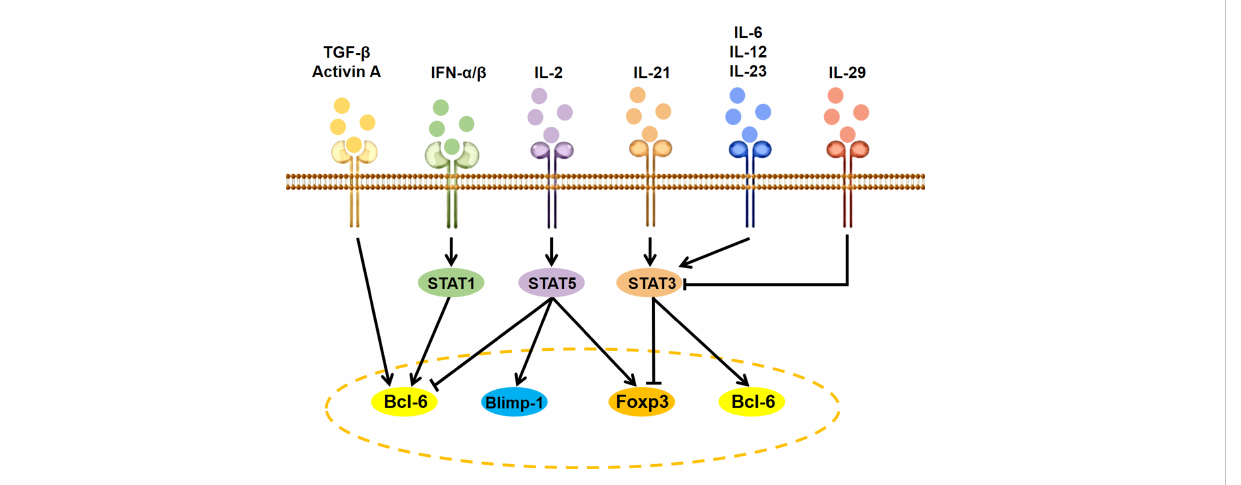
FIGURE 2 Signaling modulation of Tfh and Tfr cell differentiation. IL, interleukin; TGF, transforming growth factor; IFN, interferon; STAT, signal transducers and activators of transcription; Bcl6, B cell lymphoma 6; Foxp3, forkhead box P3; Blimp-1, B lymphocyte induced maturation protein